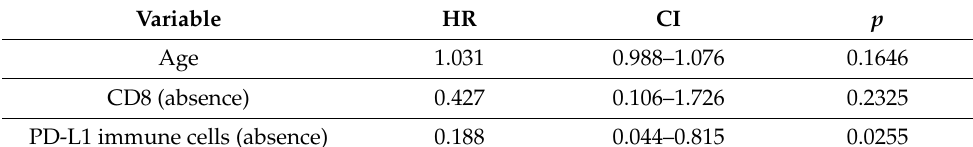
Table 5. Multivariate Cox proportional hazards regression analysis.